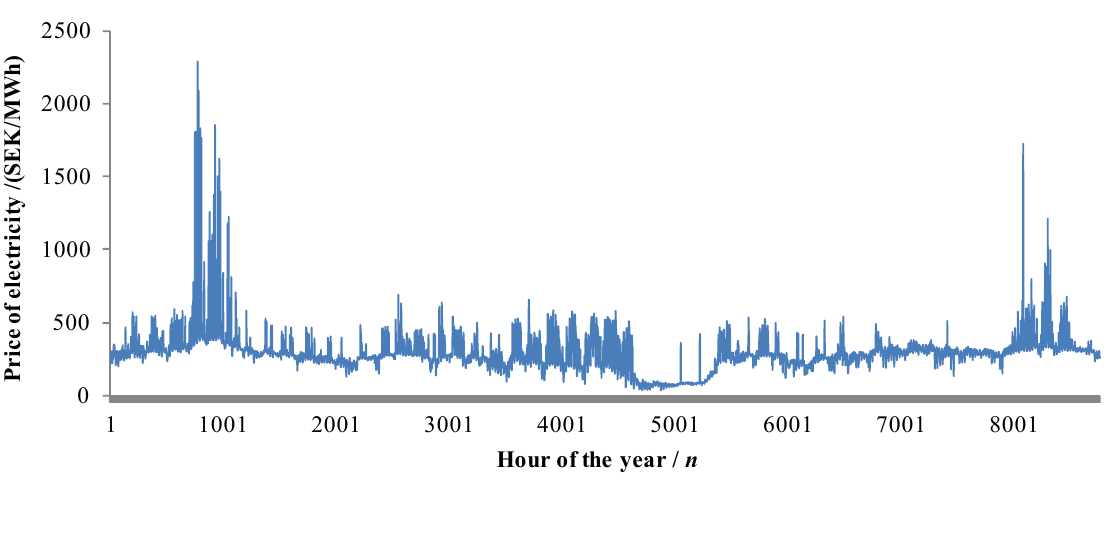
Figure 3. Hourly market electricity price from NordPoolSpot (in 2012, region SE4) [29]. Reproduced with permission from [29]. Copyright 2013